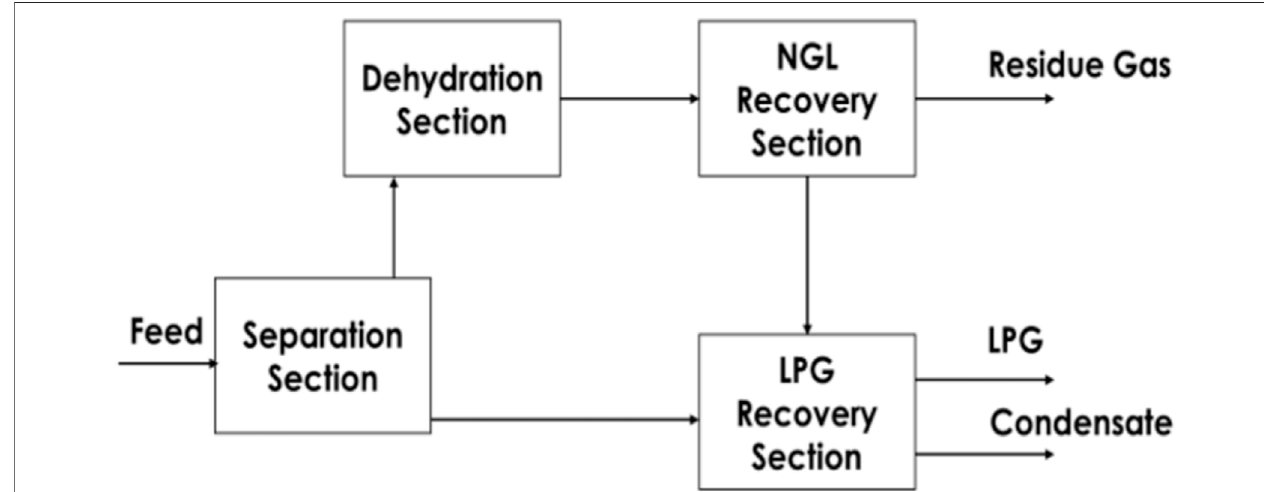
FIGURE 1 | Schematic representation for the LPG recovery process.